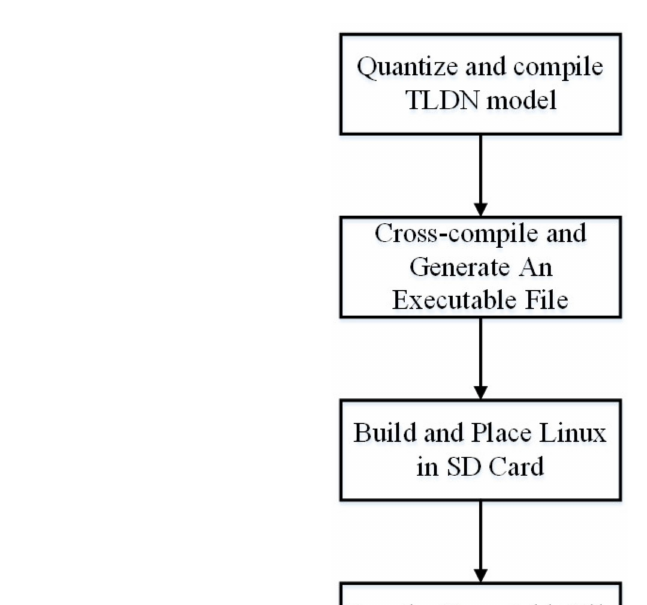
Figure 5. FPGA implementation.